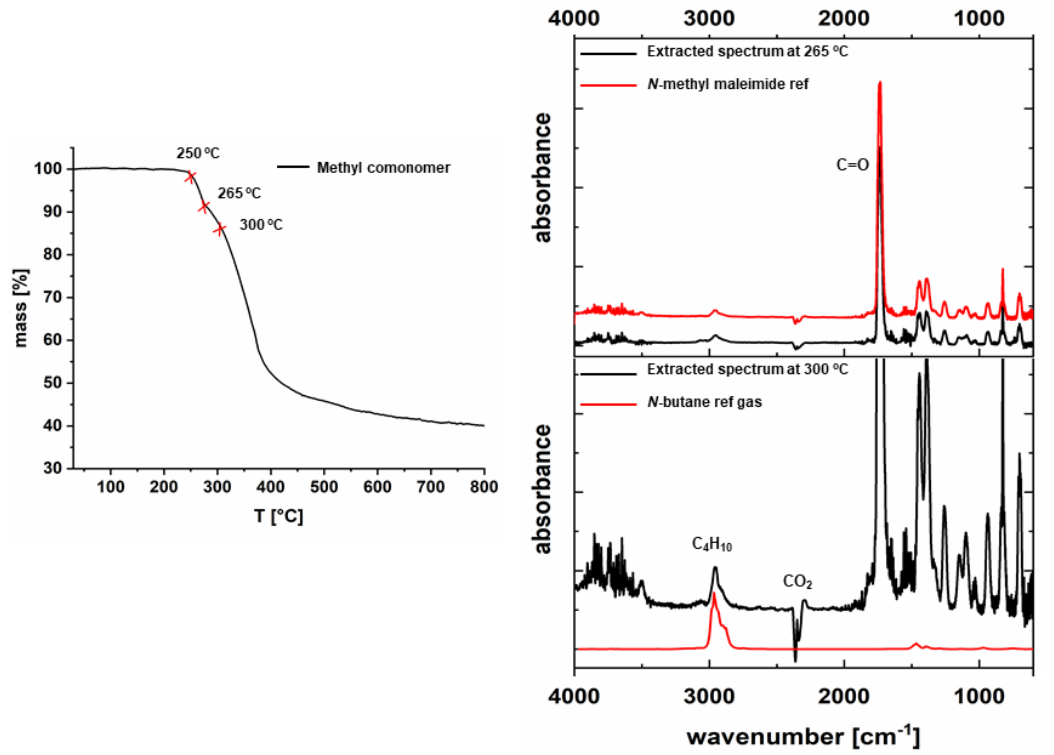
Figure 3. TG-FTIR spectra of methyl-comonomer.